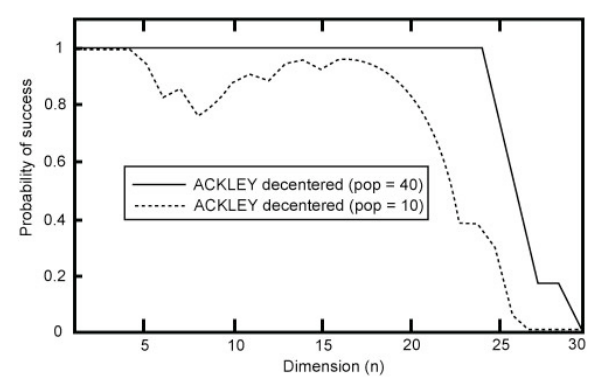
Fig. 2 – Influence of the population size (Ackley’s function)